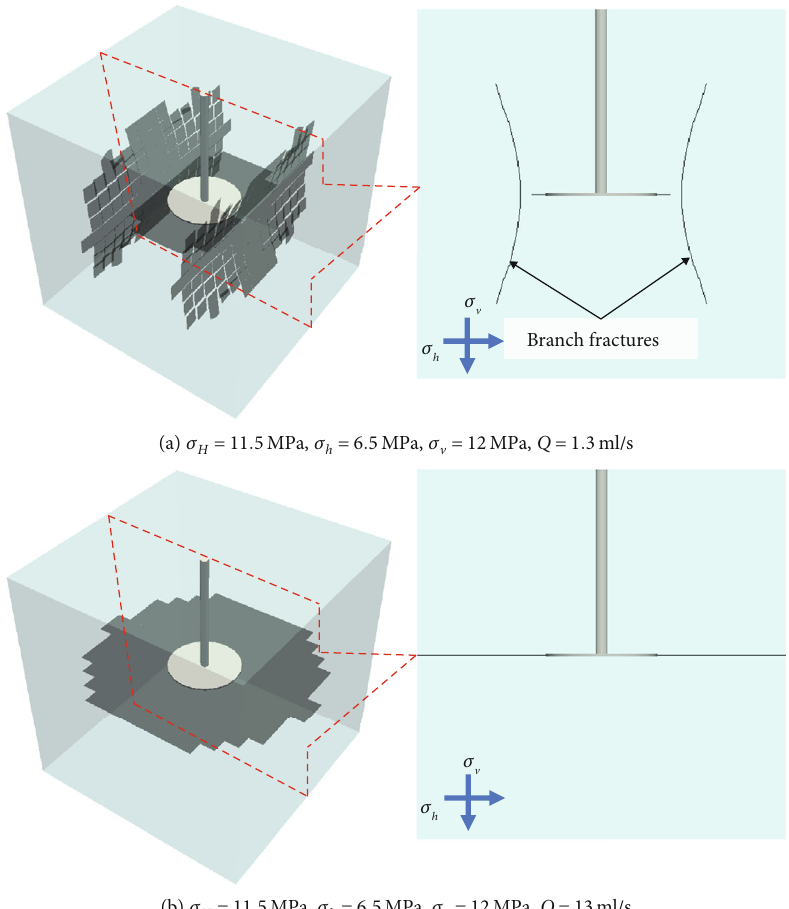
= 11 : 5MPa , σ = 6 : 5 MPa , and σ = 12MPa and injection rates H h v